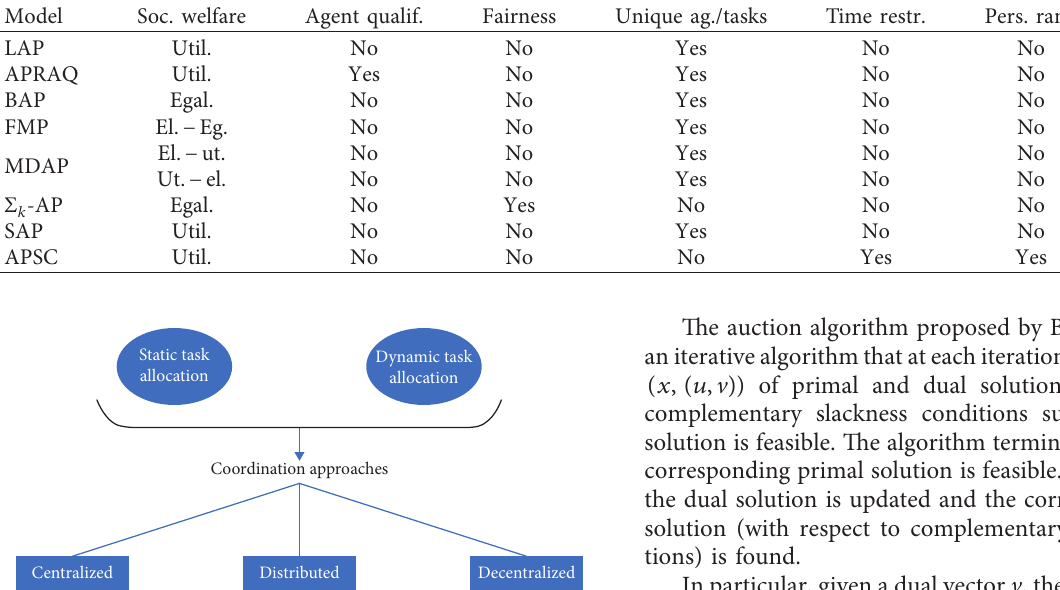
Table 1: Characteristics of the discussed task assignment models.